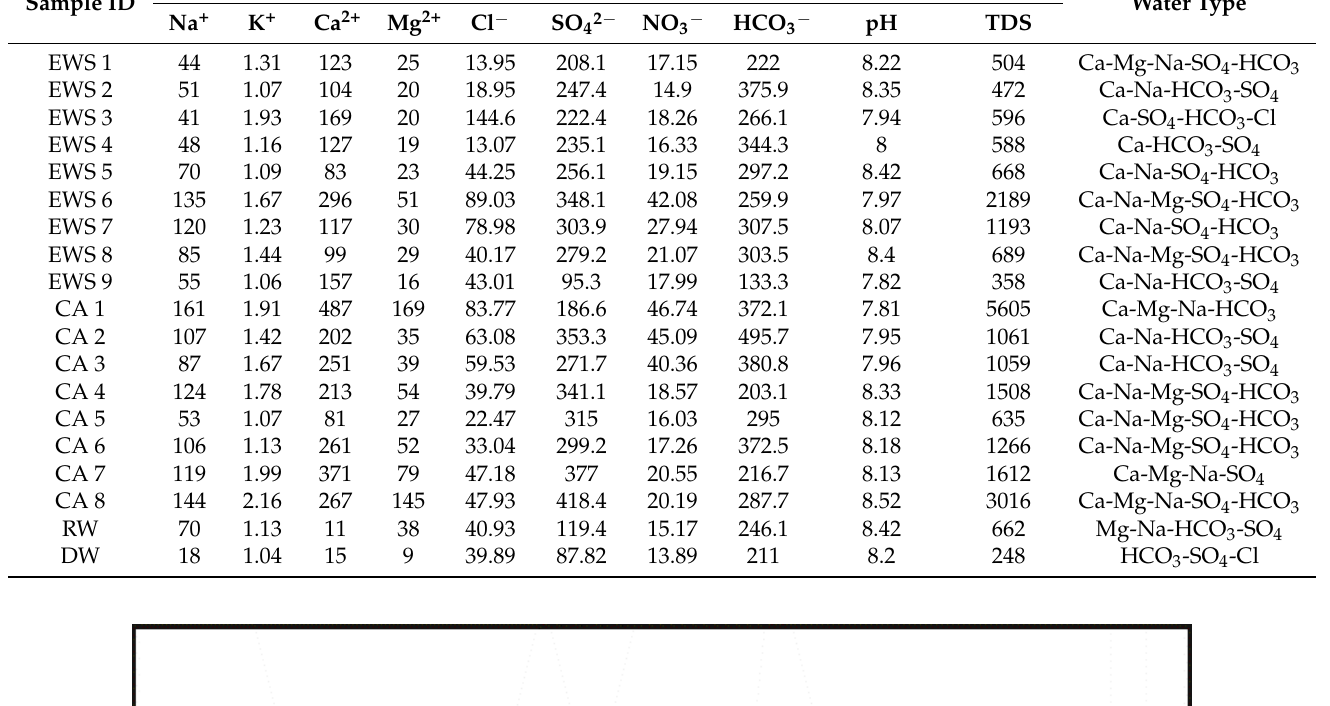
Table 2. The chemical analyses of the groundwater, river water, and dam water in Gumselasa catchment. Sample ID